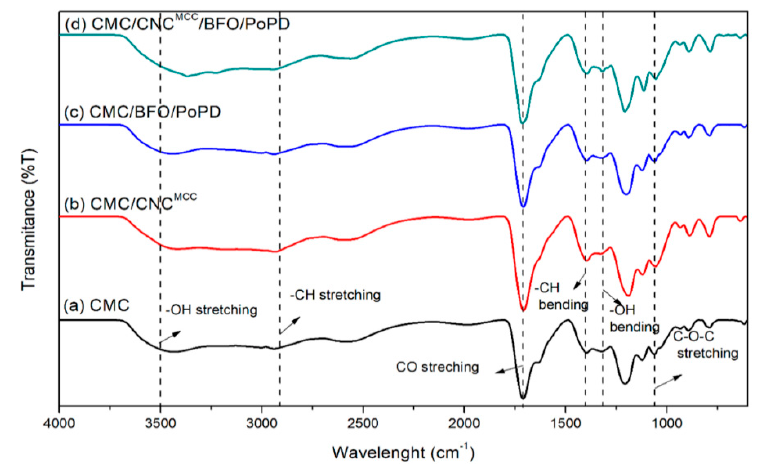
Figure 1. XRD diffractogram of ( a ) CNCs powder, ( b ) BFO powder, ( c ) PoPD powder, CMC film, CMC/BFO, CMC/BFO/PoPD, and CMC/CNC MCC /BFO/PoPD.